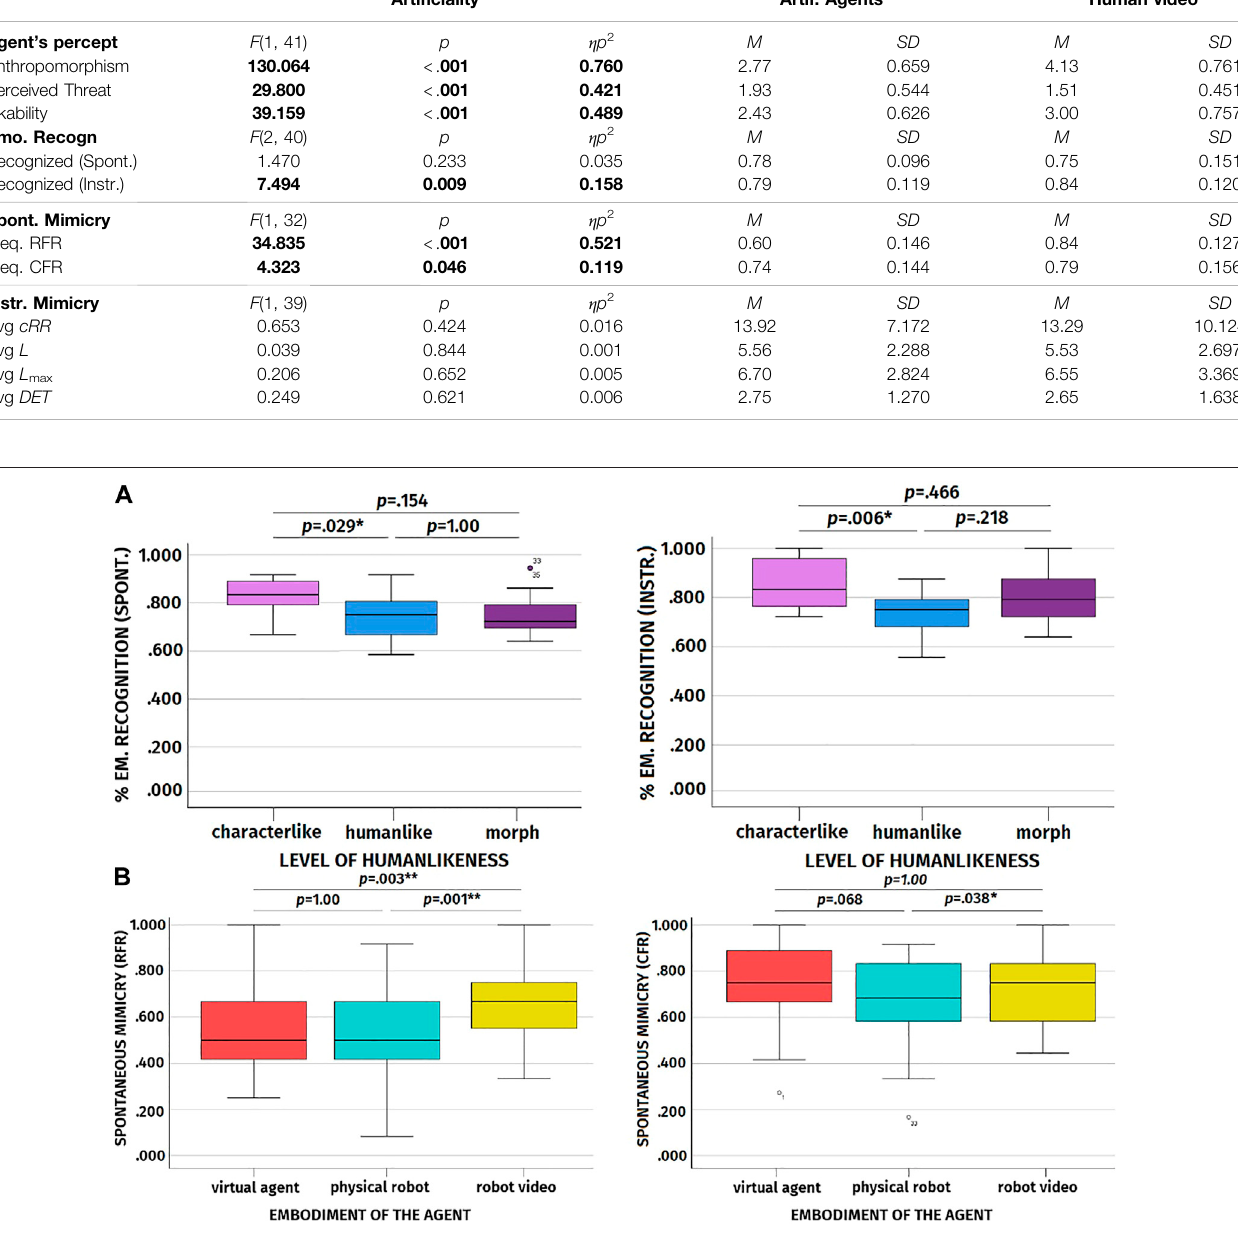
Frontiers in Robotics and AI |